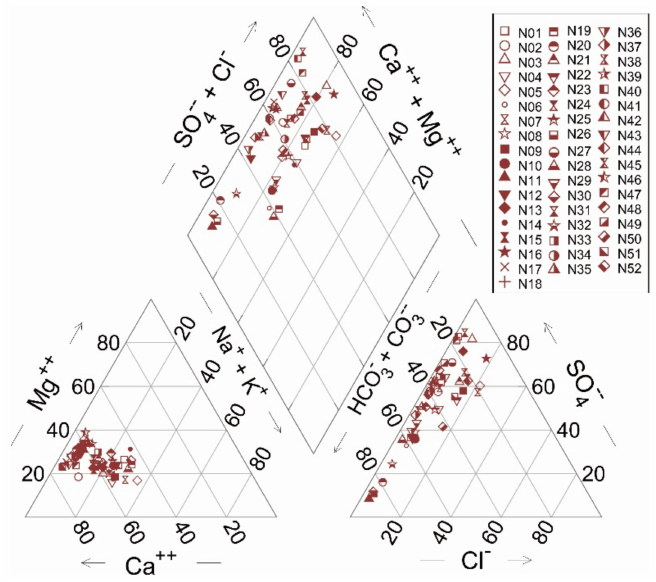
Figure 3. Piper diagram of ionic concentrations in the karst groundwater.